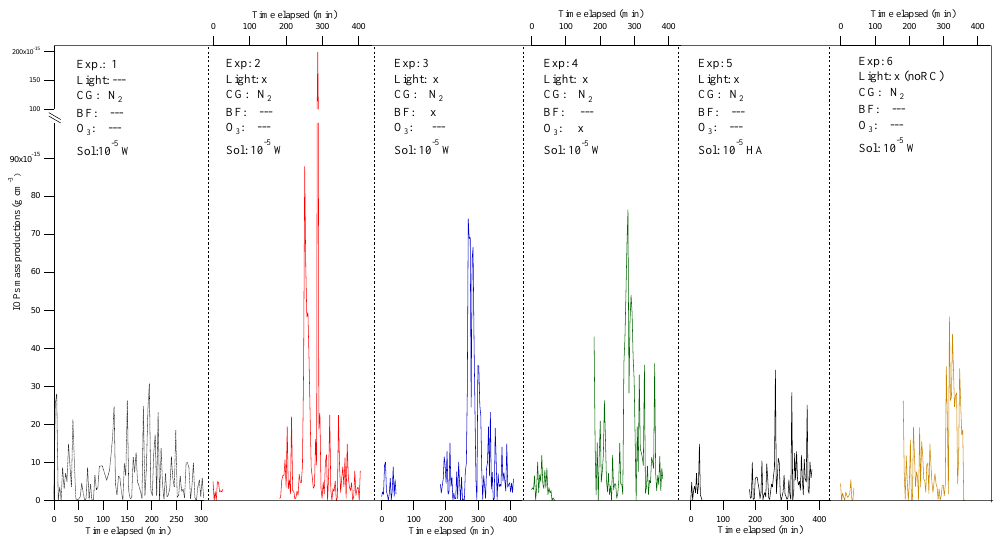
Fig. 9. Rates of IOP particle production (in gcm − 3 ) from the frozen IO − solutions under different experimental conditions as summarised 3 in Table 1. The blank is shown at the beginning of each experiment. Abbreviations: Light – solar simulator, CG – carrier gas, BF – blue filter, O 3 – ozone in the flow cell, RC – reaction cell, Sol – solutions (W: water, HA: humic acid). An “x” represents an active parameter while “—” represents an inactive